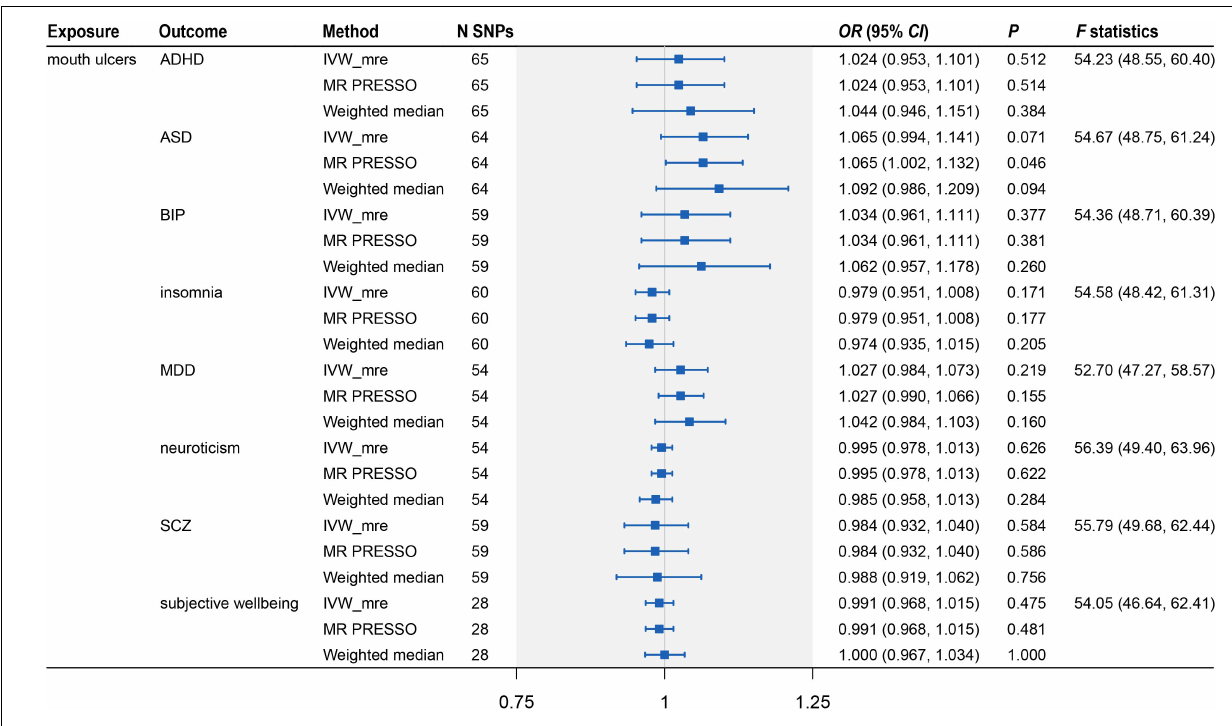
FIGURE 5 | Two-sample Mendelian randomization analysis showing the effect of mouth ulcers on eight psychiatric traits. ADHD, attention deficit/hyperactivity disorder; ASD, autism spectrum disorder; BIP, bipolar disorder; MDD, major depressive disorder; SCZ, schizophrenia; IVW_mre, inverse variance weighted with multiplicative random effects; MR-PRESSO, Mendelian randomization pleiotropy residual sum and outlier; N SNP, number of the instrumental SNPs used to conduct MR analyses; Effect estimates express the change in odds ratio ( OR ) per standard deviation ( SD ) increment in mouth ulcers, error bars indicate 95% confidence